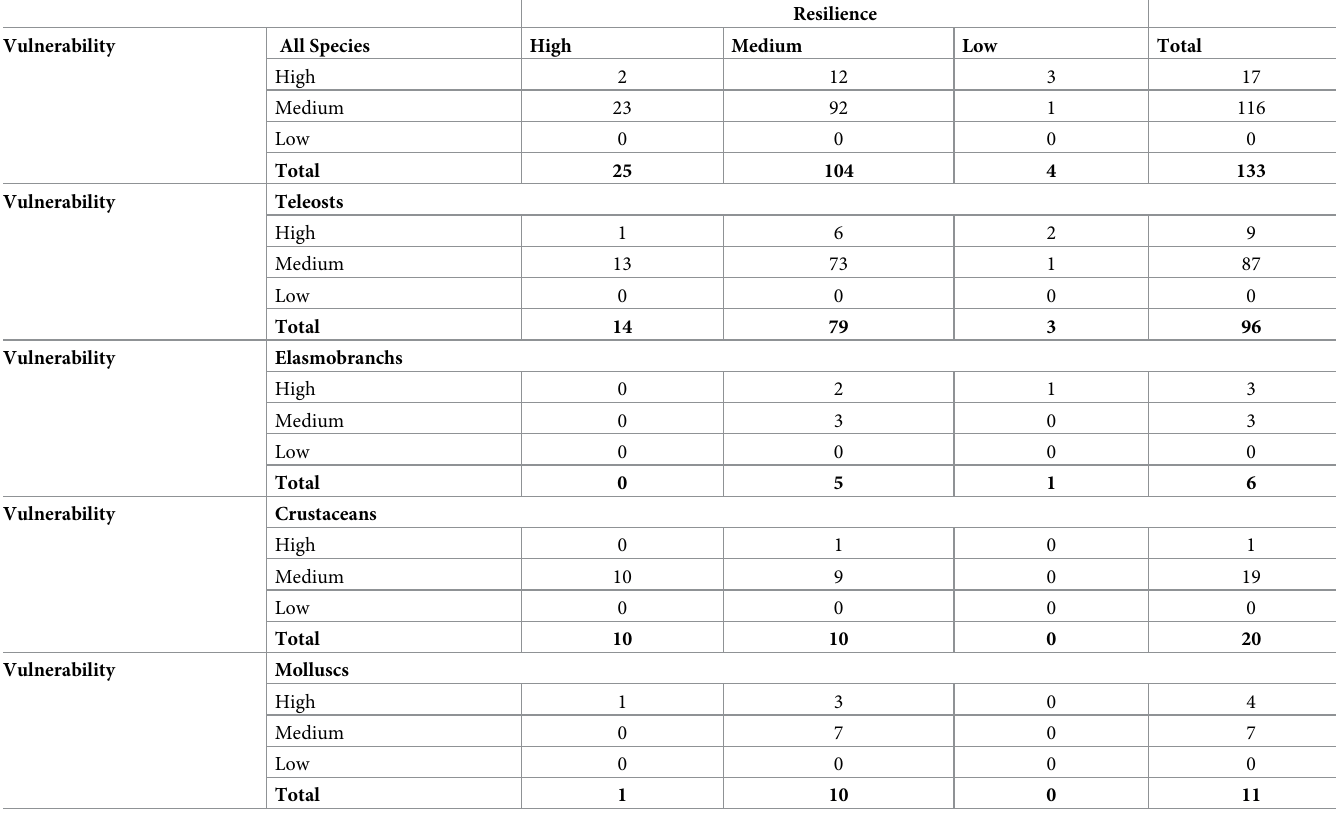
Table 4. Contingency matrix of R and V scores for all species, teleosts, elasmobranchs, crustaceans and molluscs based on Low— < 1.5; Medium— > = 1.5 & < 2.5 and High > 2.5 scores.